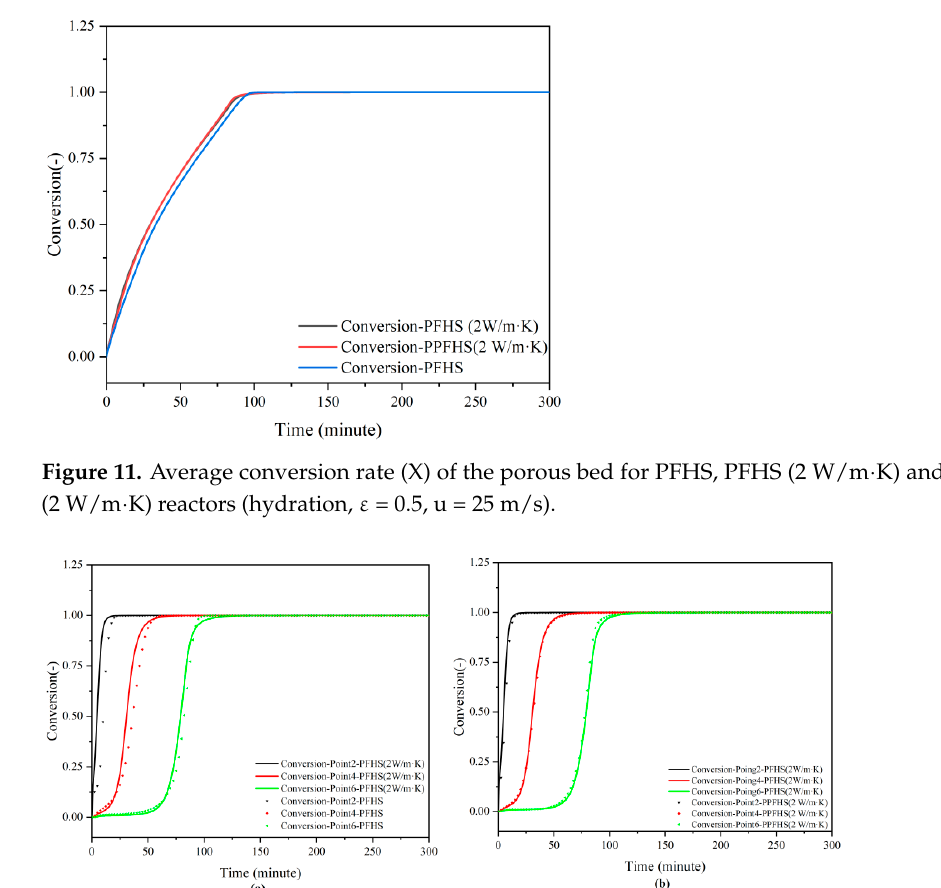
Figure 10. The average temperature (T) and conversion (X) of the material changed over time in the